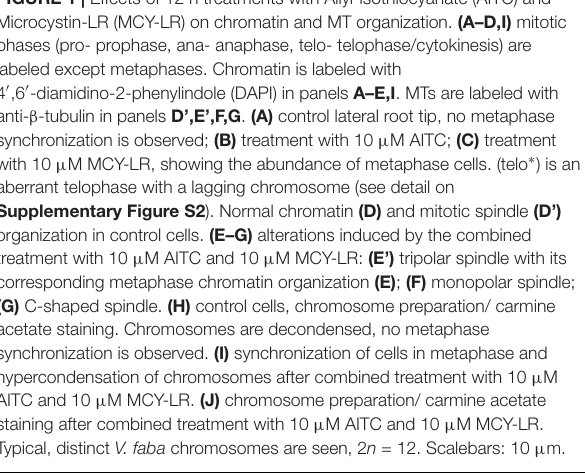
the 2 n = 2 x = 12 chromosome number characteristic for V. faba